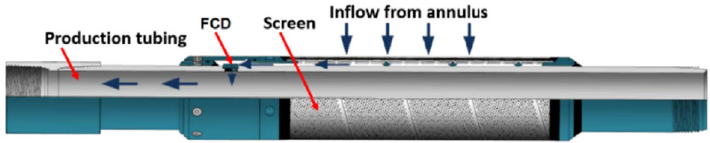
Figure 1. Schematic of advanced well completion with FCD and SCS [2].